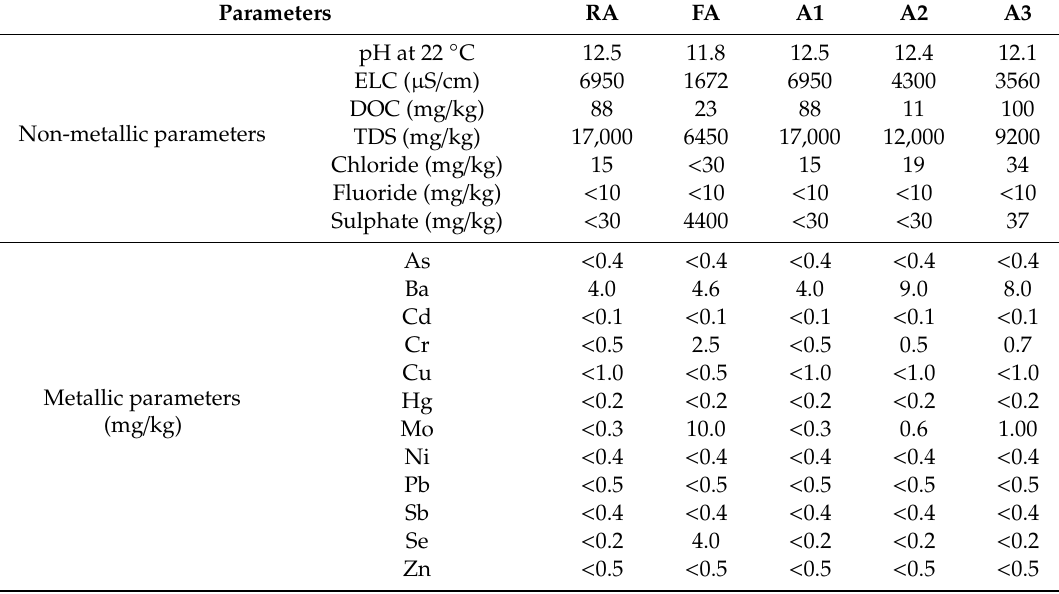
Table 7. Data of the chemical characterization of the eluate samples. Parameters